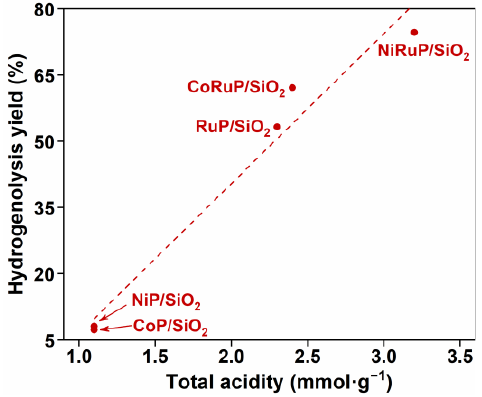
Figure 7. Linear correlation between the total acidity and hydrogenolysis yield.